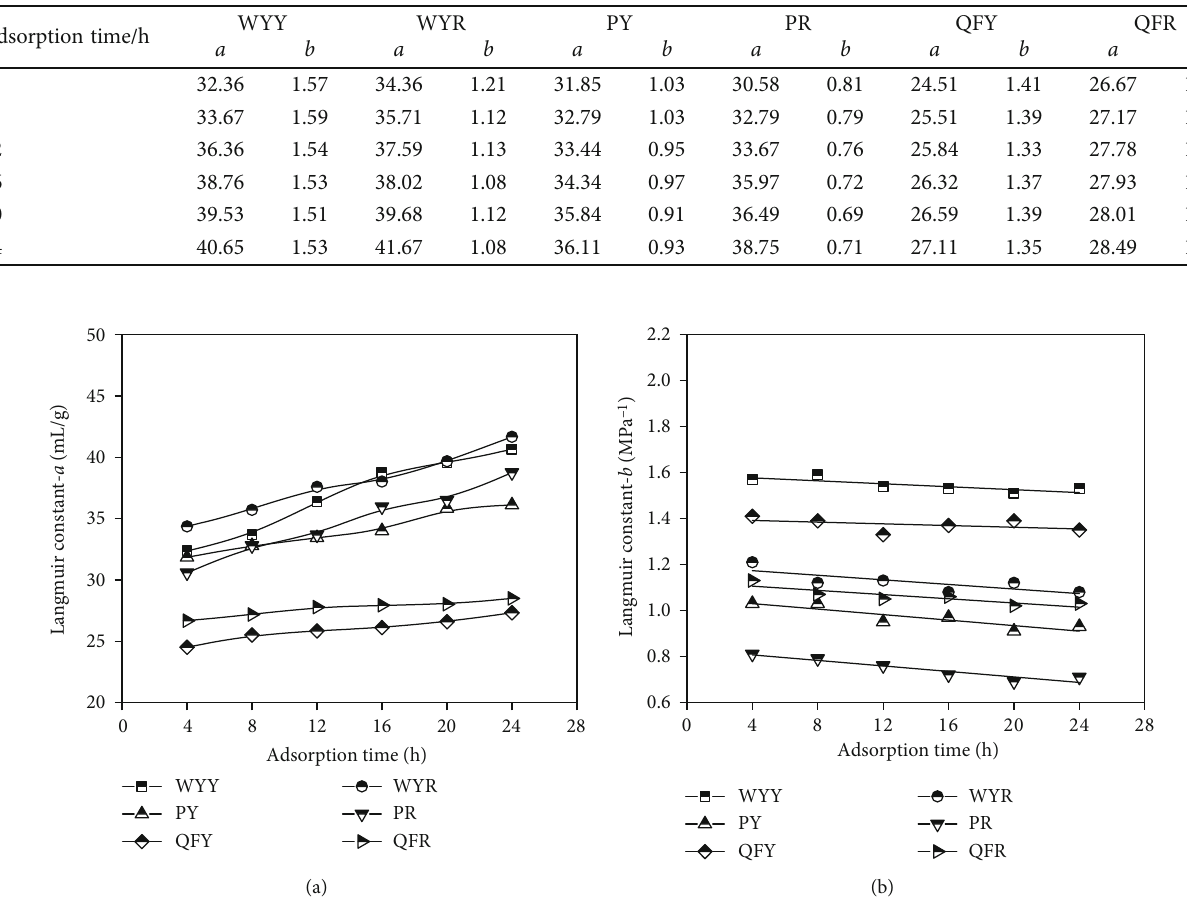
Figure 8: Langmuir constants at di ff erent adsorption time: (a) is the Langmuir constant a ; (b) is the Langmuir constant b Table 6: CBM content and numerical percentage of the maximum value at di ff erent adsorption time. Adsorption time/h